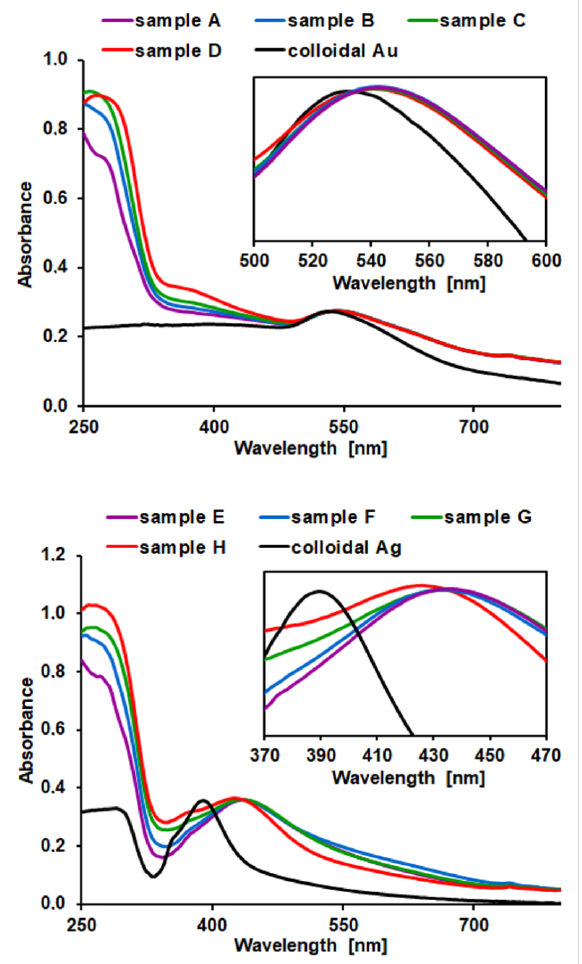
Figure 3: Normalized UV–vis spectra of noble metal colloids and noble metal@TiO 2 core–shell nanostructures for Au (top) and Ag (down). All spectra were normalized to the peaks relative to the surface plasmon resonances of